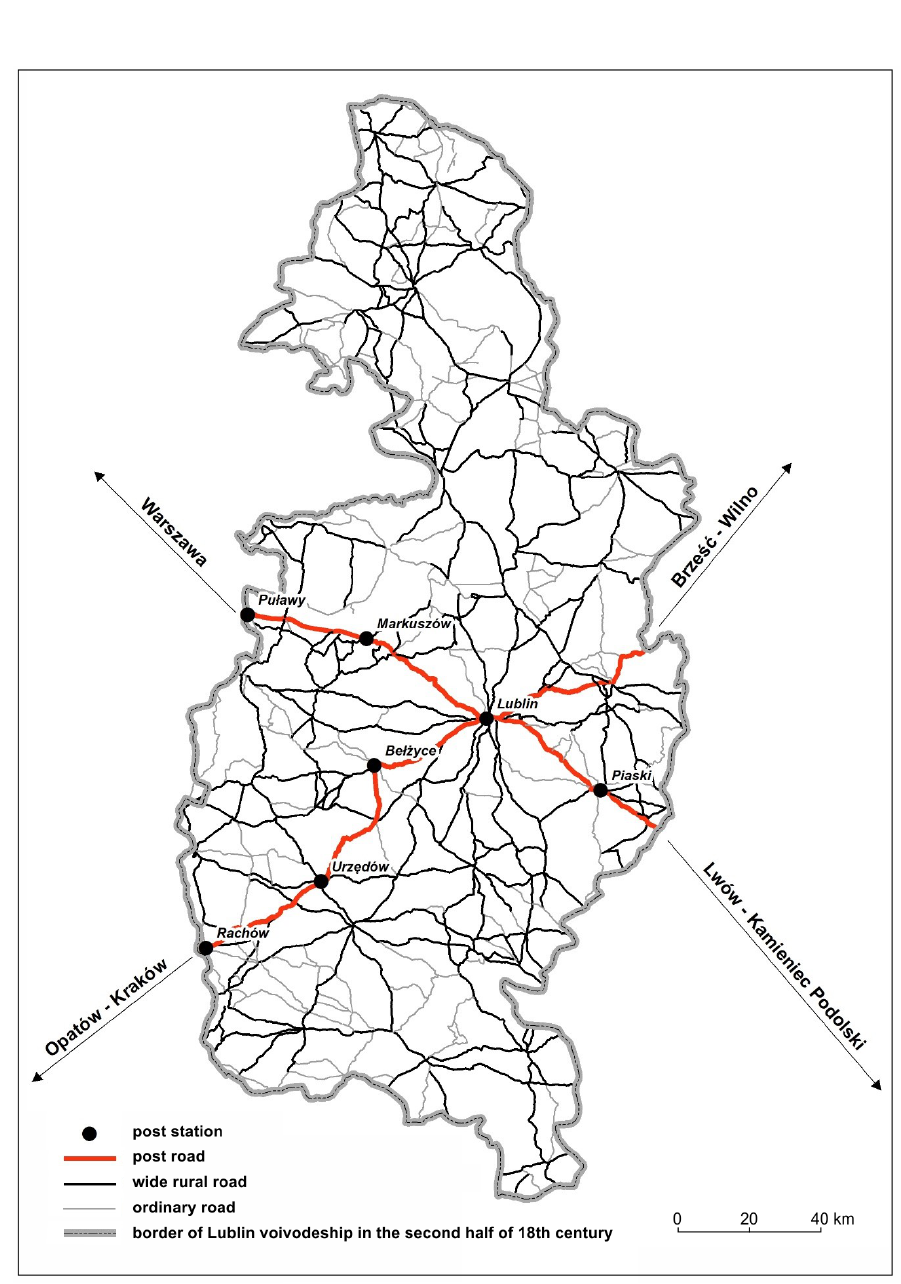
Fig. 1. Map of postal roads considering the communication network of the Lublin Voivodeship in the second half of the 18th century (the author’s